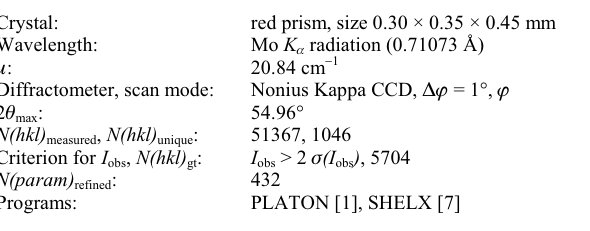
Table 1. Data collection and